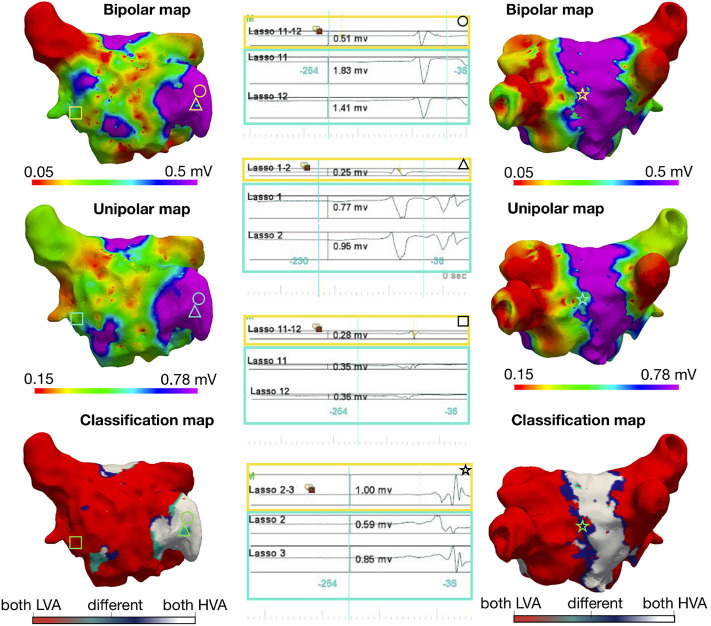
Voltage mapping in sinus rhythm: Three-dimensional distribution of bipolar and unipolar LVA in a patient during SR with a bipolar threshold <0.5 mV. The top row indicates the bipolar map, the middle row shows the unipolar map, and the bottom row is a map of the point by point comparison between the two maps: if both points are below their indicated voltage thresholds (LVA), the point is colored red, if both are above [high voltage areas (HVA)] in white and with different classification (bipolar low voltage, unipolar high voltage) in dark-blue and (bipolar high voltage, unipolar low voltage) in turquoise. In the left column, the anterior view is shown and on the right the posterior view. Each geometric shape represents a point on the map where the corresponding signal is shown in the middle column. The upper unipolar threshold values were obtained by determining which threshold provided the best match of points between unipolar and bipolar. For visualization, the lower value was manually optimized to obtain the best visual match.